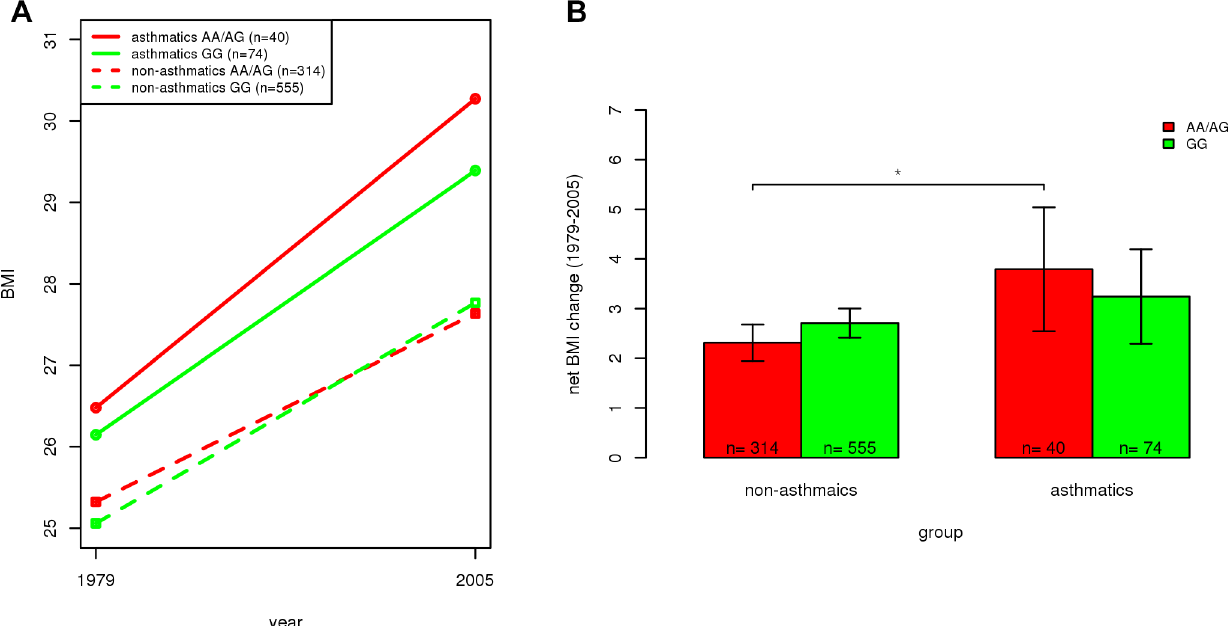
Fig 5. Association of rs2107212 genotypes and BMI change by asthma status in FHS. A: For a subset of FHS subjects who had BMI and asthma information at both exam 2 (1979) and exam 8 (2005) (n = 983), the means of BMI at both time points are shown according to the rs2107212 genotypes AA/ AG and GG, stratified by asthma status. B: Net BMI change (BMI value in 2005 — BMI value in 1979) with rs2107212 genotypes AA/AG and GG stratified by asthma status is shown. The numbers of subjects are shown in each bar. Data are represented as the mean ± SEM. * p < 0.05 under Welch ’ s t-test.